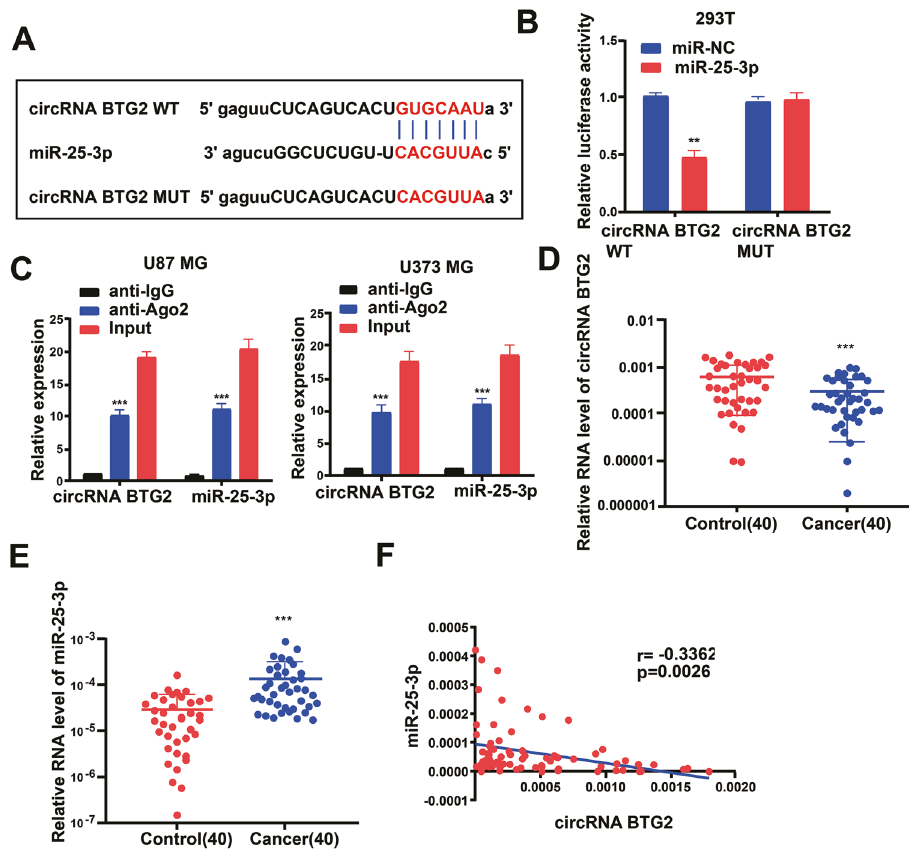
Fig. 5 circRNA BTG2 acts as a sponge for miR-25-3p. A Putative complementary sites within miR-25-3p and circRNA BTG2 were predicted by bioinformatics analysis. B Dual-luciferase reporter assays demonstrate that miR-25-3p is a direct target of circRNA BTG2 in 293 T cells. C The Ago2 RIP showed that Ago2 signi fi cantly enriched circRNA BTG2 and miR-25-3p. D The expression level of circRNA BTG2 in 40 glioma tissues and matched para-carcinoma normal tissues was determined by qRT-PCR. E The expression level of miR-25-3p in the above tissues was determined by qRT-PCR. F The expression levels of miR-25-3p are negatively correlated with circRNA BTG2 in glioma tissues. ** P < 0.01 and *** P < 0.001 for statistical differences.